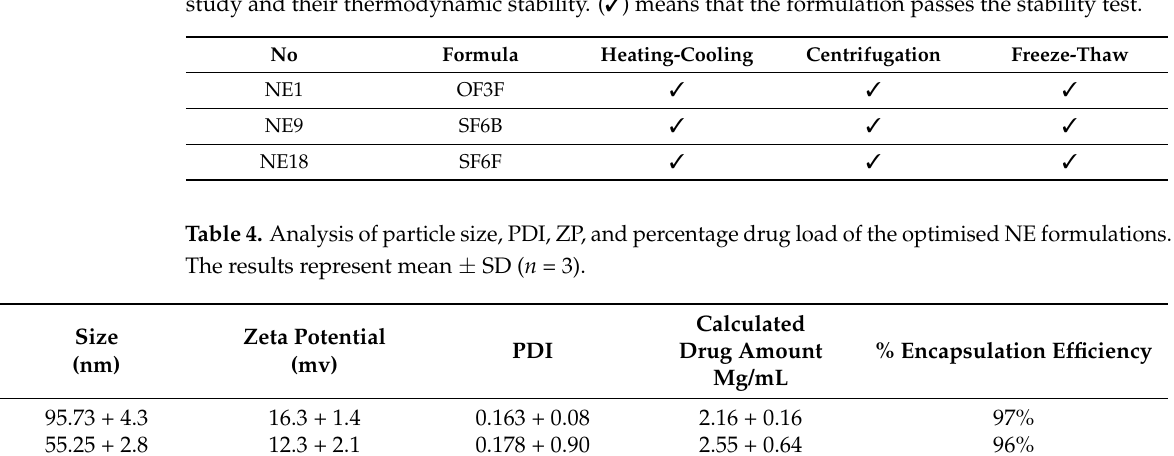
Table 3. Few TAM-NE formulations have achieved acceptable results following a phase behaviour study and their thermodynamic stability. ( (cid:51) ) means that the formulation passes the stability test.